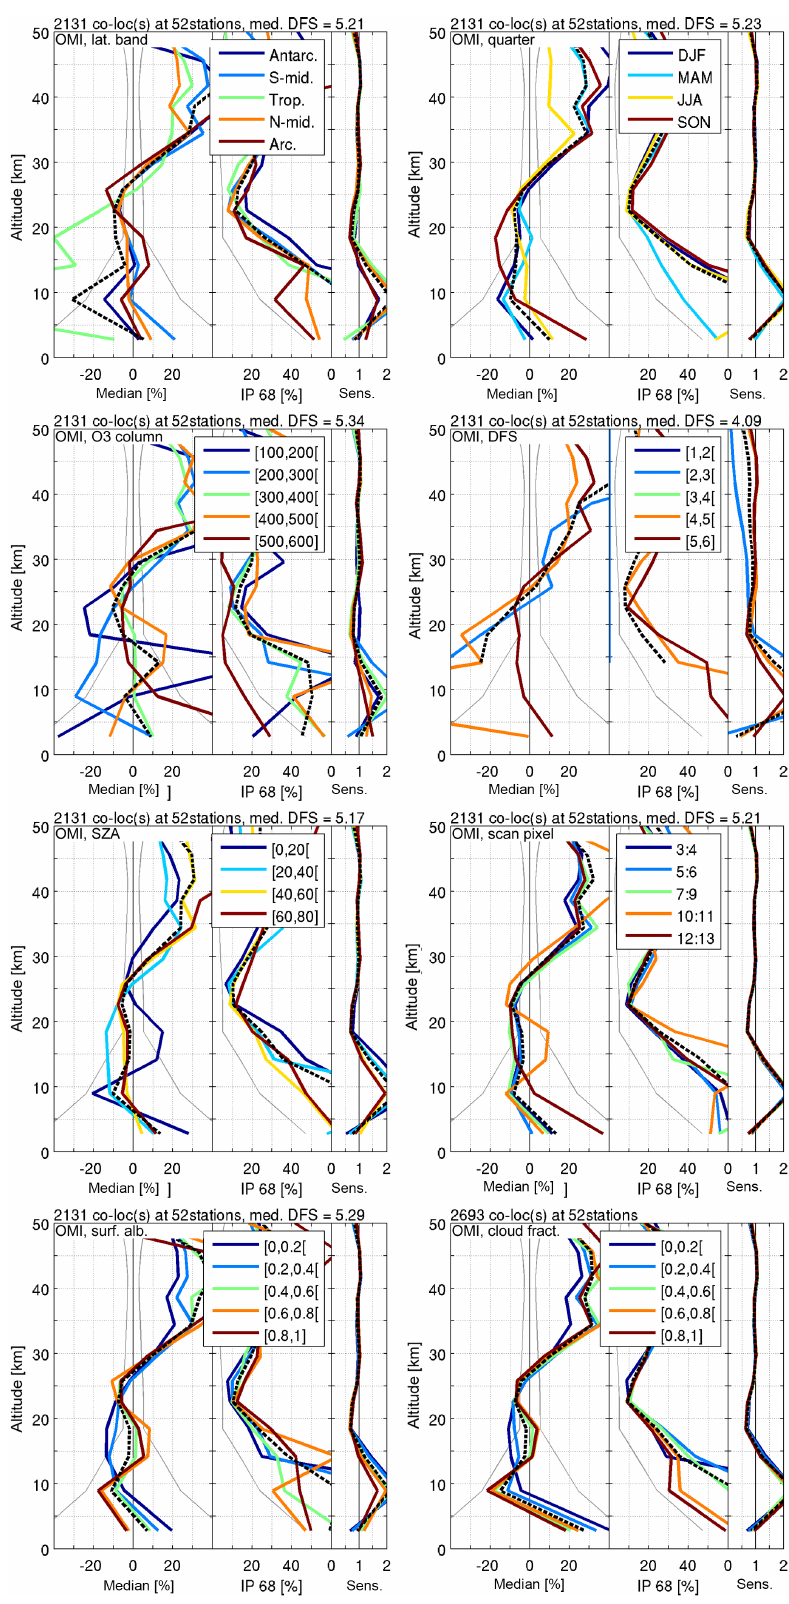
Figure 10. As for Fig. 6, but for RAL v2.14 L2 OMI data